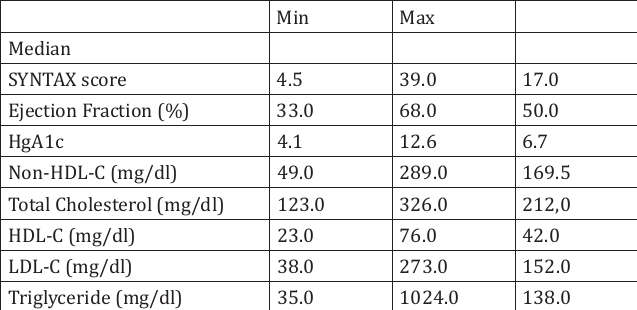
SYNTAX score, EF and biochemical variables of